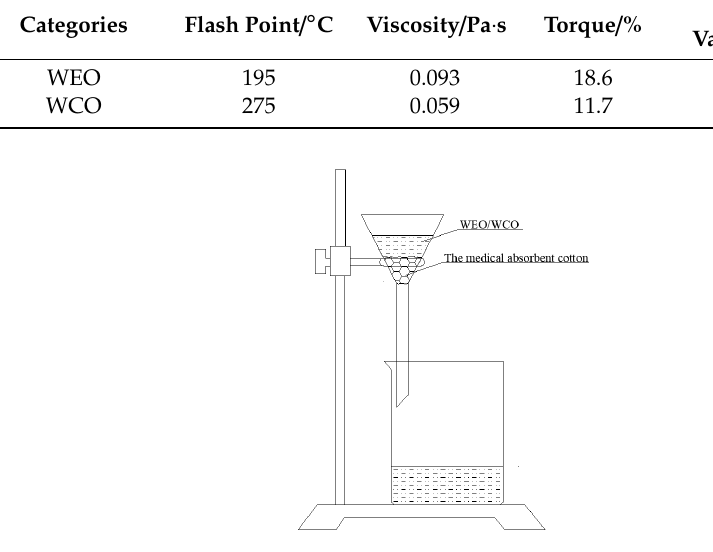
Figure 1. The filter device.